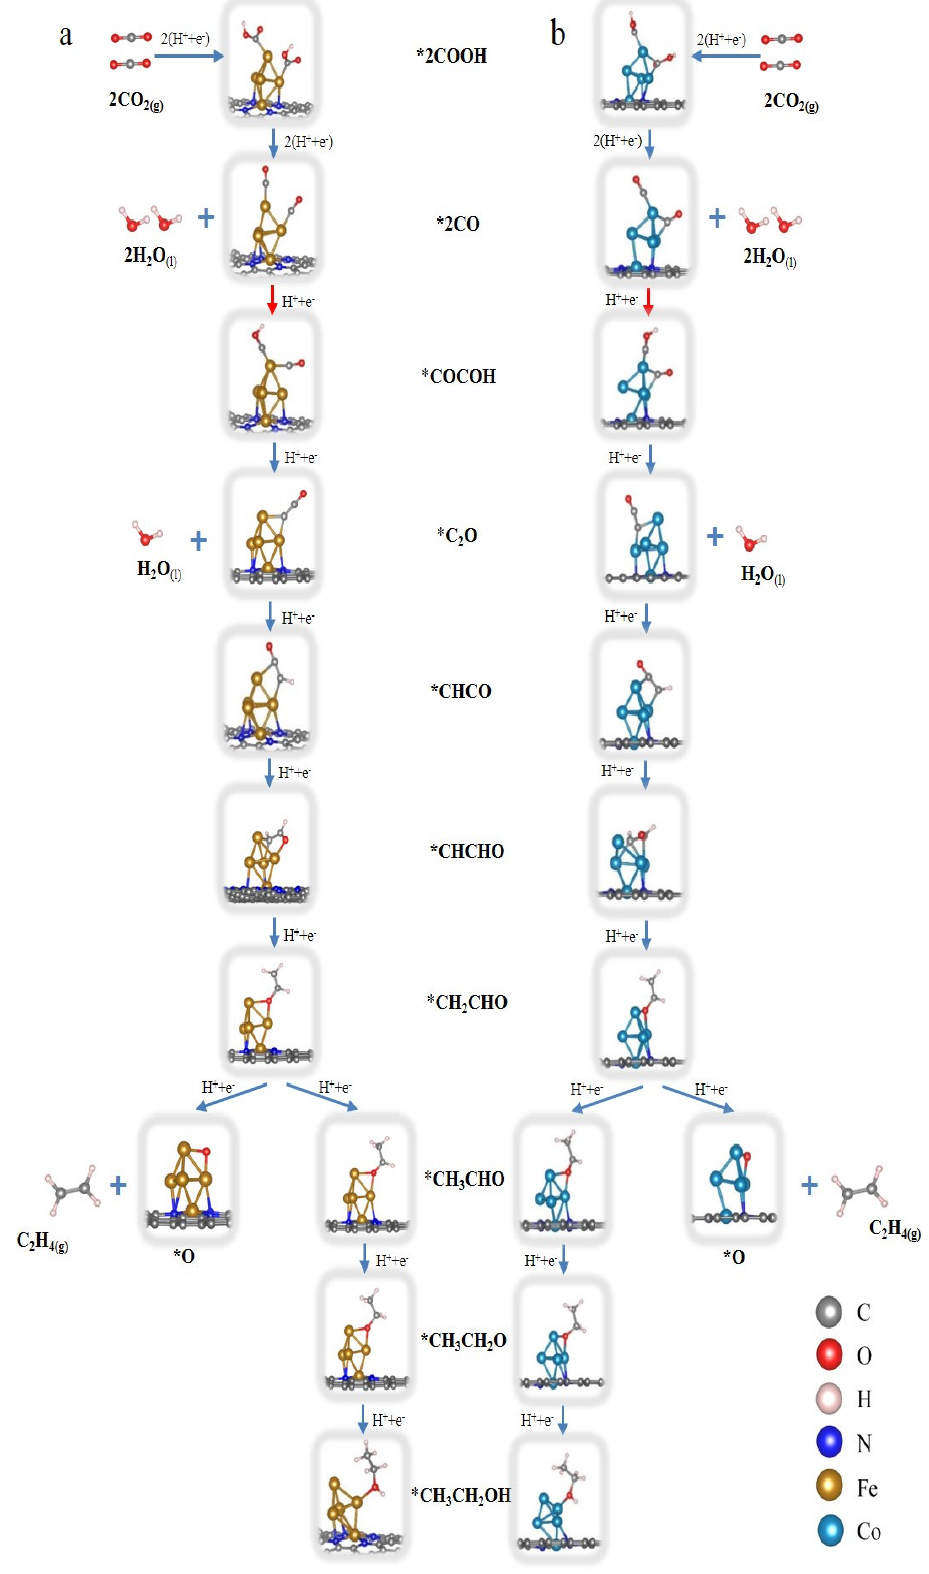
Figure 3. Optimized structures of intermediate Fe 5 -NC ( a ) and Co 5 -NC catalysts ( b ) during the CO 2 RR process.